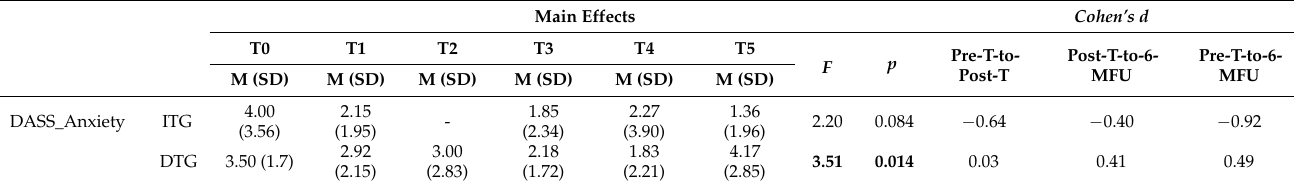
Table 4. Post hoc analyses for the